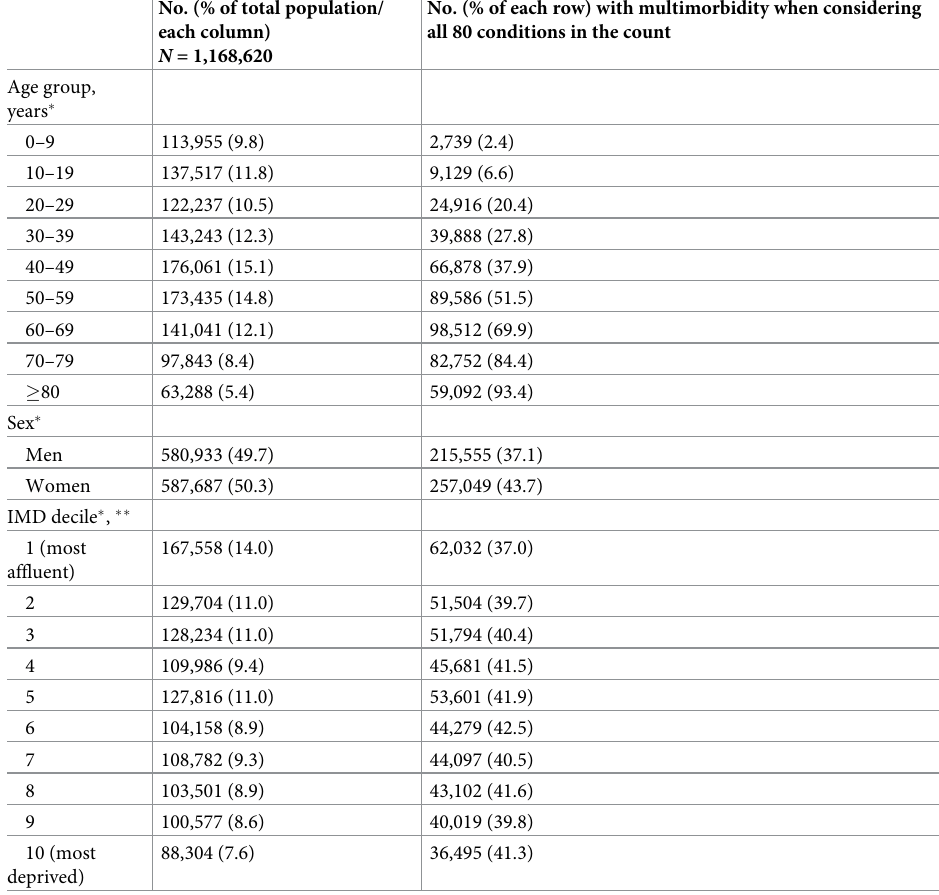
Table 1. Population